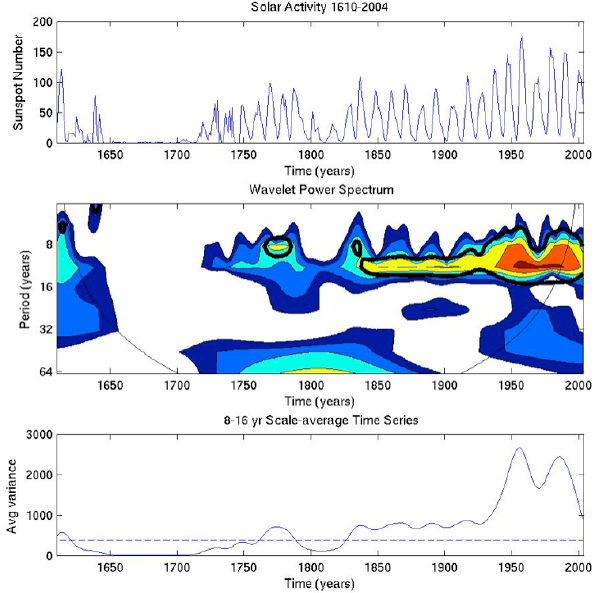
Fig. 2. Upper panel shows the group sunspot number from 1610 to 1995 and the sunspot number up to 2004. Middle panel shows the wavelet power spectra, with a cone of avoidance and enclosed regions of greater than 95% confidence level (thick black solid line). Lower panel shows the average variance. The Maunder and Dalton minima are clearly seen as well as the dramatic change after about 1940.